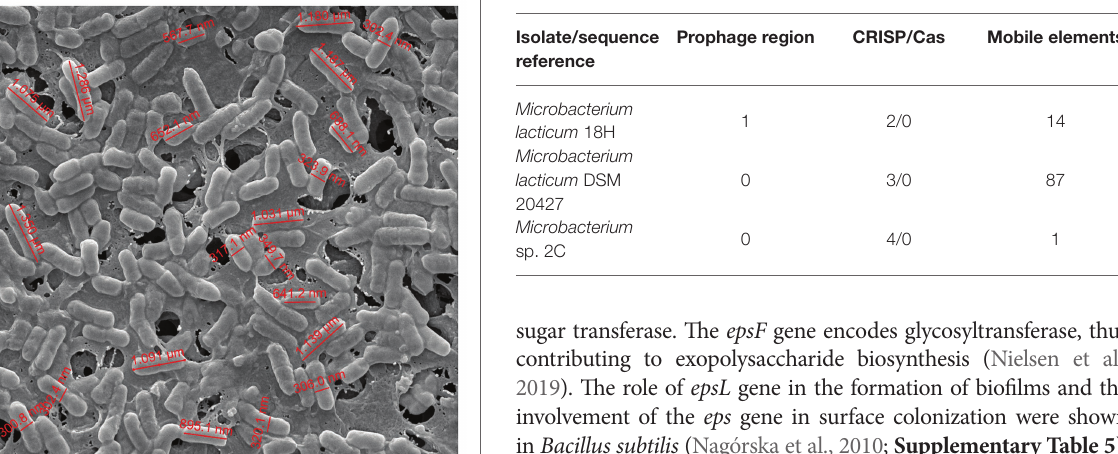
TABLE 4 | General features of the three genomes of Microbacterium .